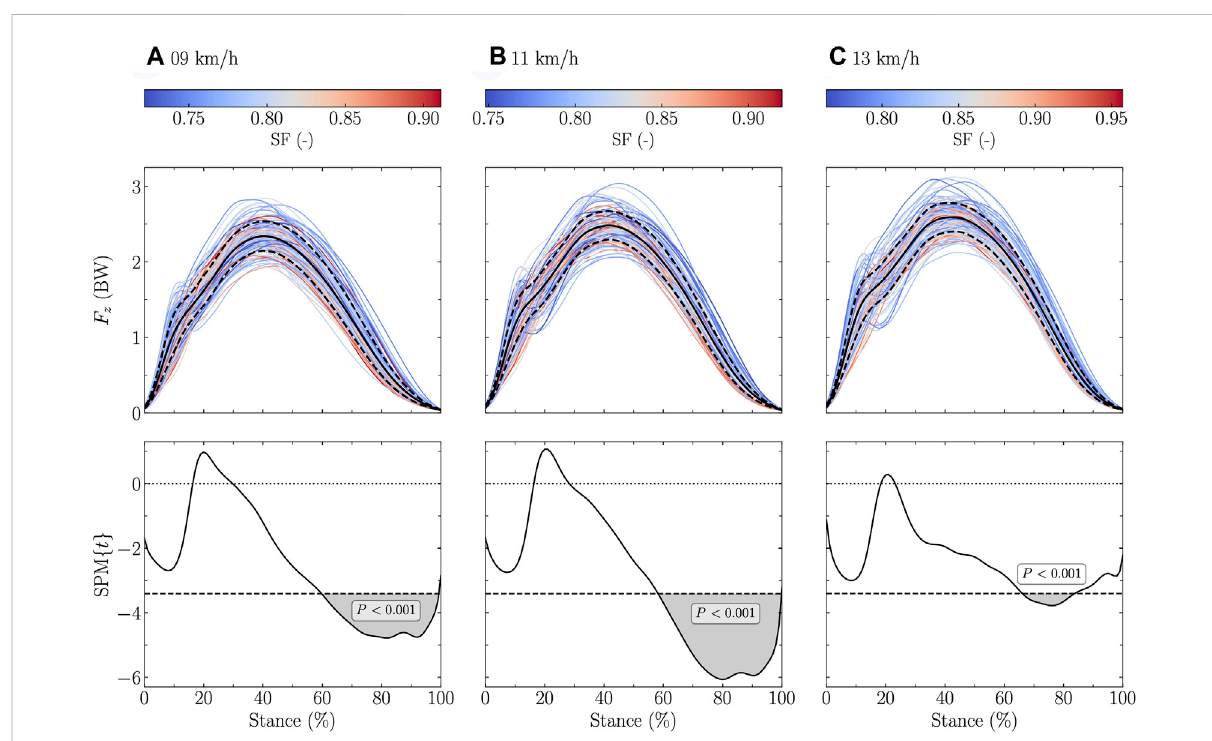
FIGURE 2 Statistical parametric mapping (SPM) analysis, i.e., t-statistics (SPM{t}), of the linear relationship between the vertical ground reaction force (F z ) (cid:1)(cid:1)(cid:1)(cid:1) (cid:3) and the step frequency (SF) normalized by g / L 0 , where g is the gravitational constant and L 0 the leg length, along the running stance phase at (A) 9 km/h, (B) 11 km/h, and (C) 13 km/h. In the upper panels, F z , expressed in body weight (BW), is depicted for each participant (the color depends on the DF value) and for the mean (black line) ± standard deviation (dashed black line) over all participants. In the lower panels, the black dashed horizontal lines represent the critical (parametric) threshold while the portion of the running stance phase which is statistically signi fi cant ( p ≤ 0.017; Bonferroni correction was applied to take into the three tested speeds) is given by the gray shaded